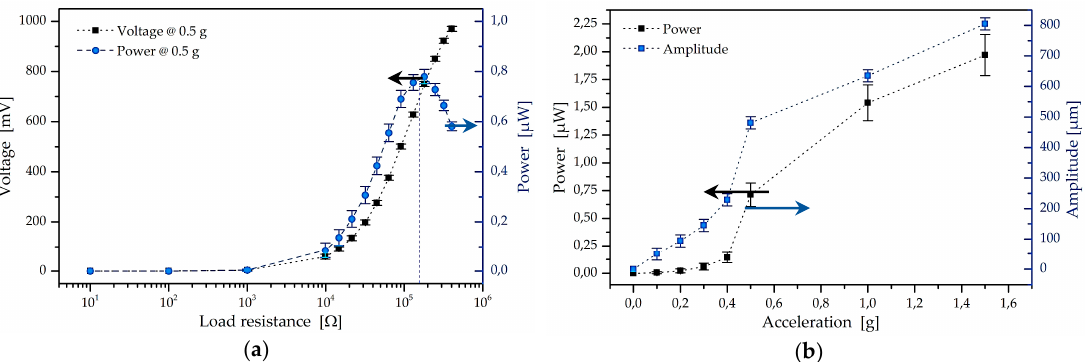
Figure 4. ( a ) Peak-to-peak voltage and generated power as a function of load resistance at the harvester resonance frequency and 0.5 g acceleration; ( b ) Generated power and amplitude as a function of acceleration at the resonance frequency and optimal load